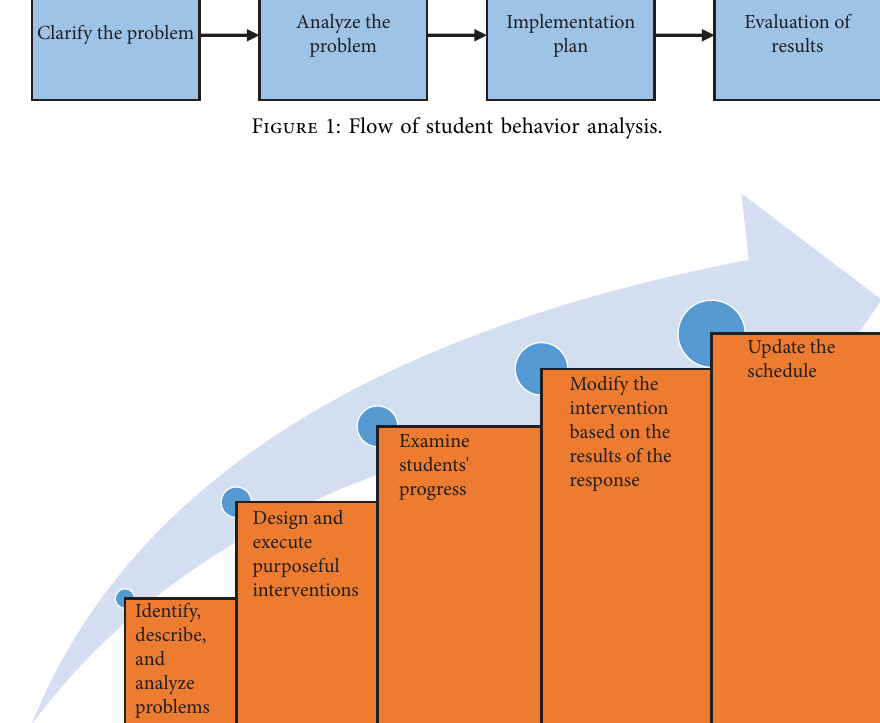
Figure 2: Te fow of the deep intervention model.